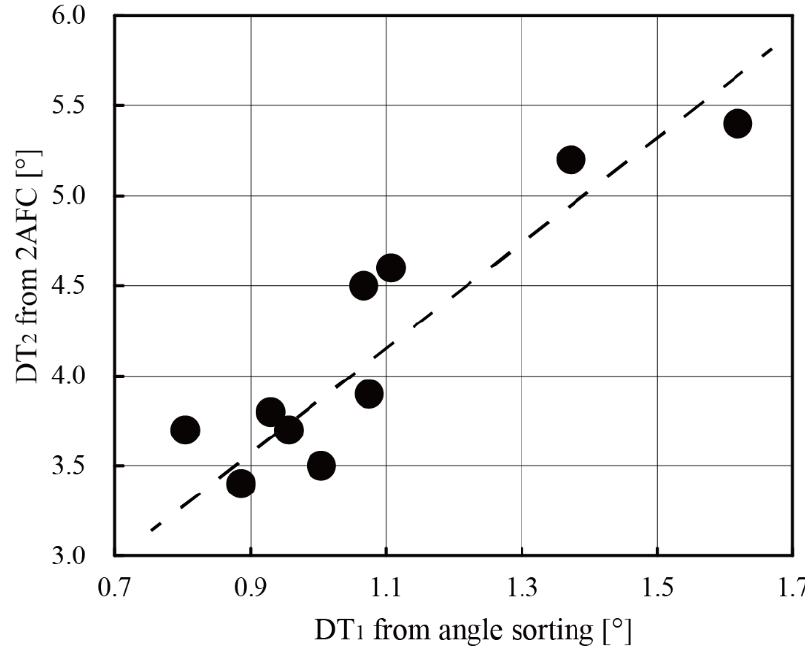
Figure 11. Each participant’s DT from angle sorting and 2AFC.